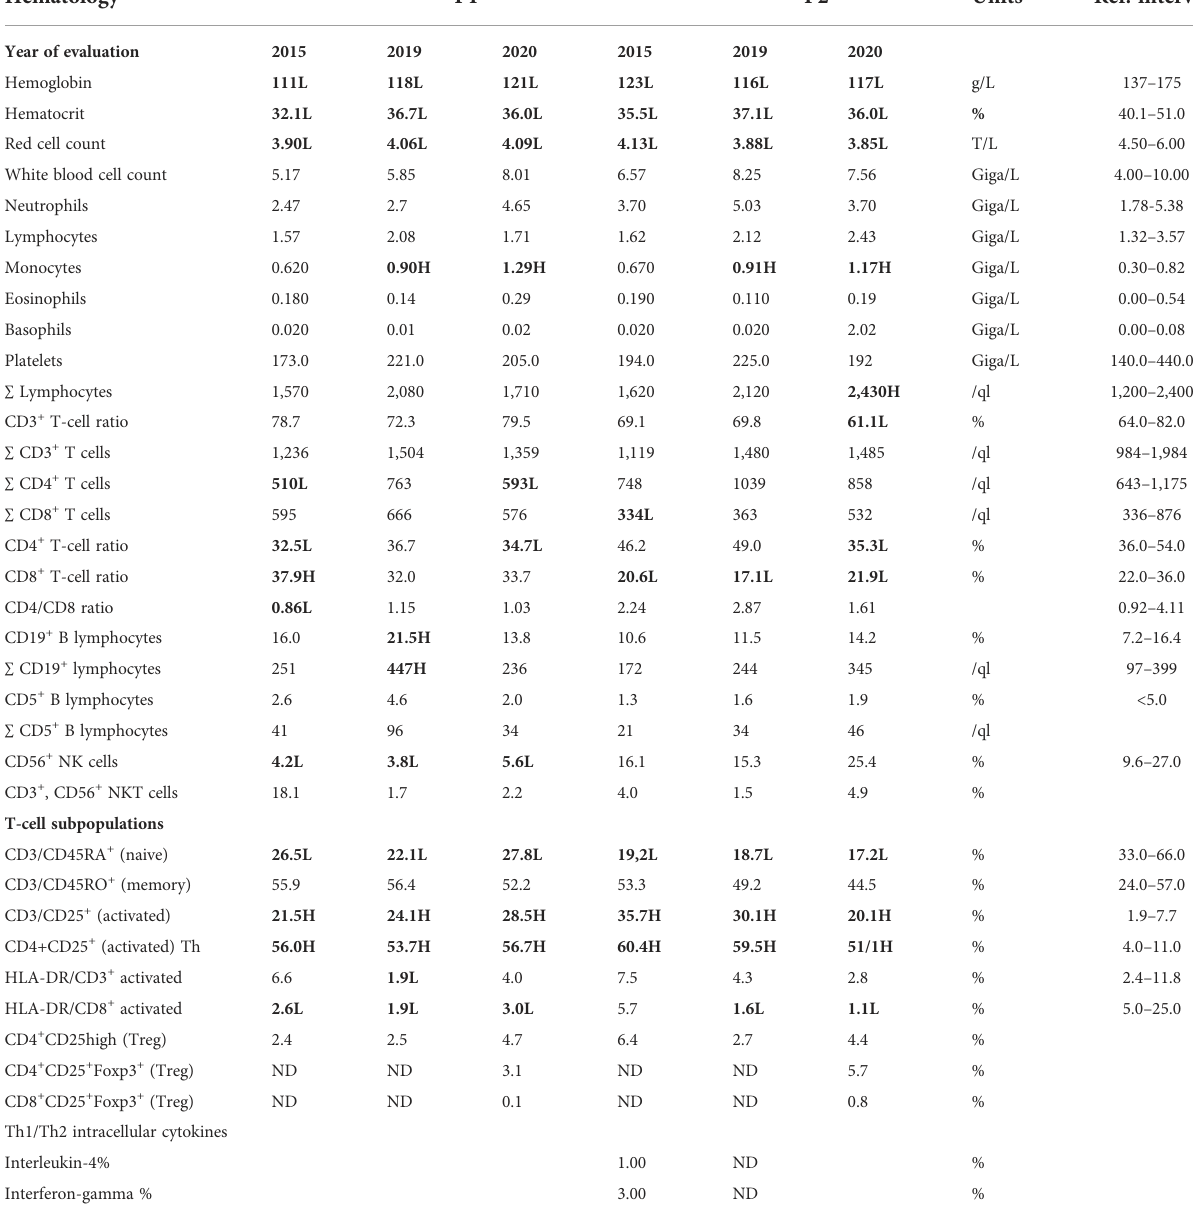
TABLE 2 Hematology, immunohematology II, and FOXP3 staining results (ND, not determined; H, high; L, low).